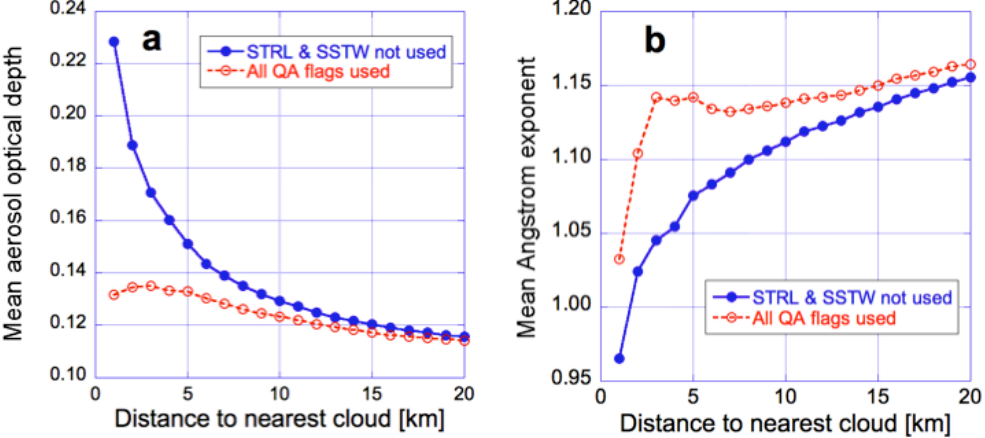
Figure 3. Near-cloud behavior of ( a ) mean 550 nm AOD ( b ) and mean 443–869 nm Angstrom exponent (AE) when using two different sets of Quality Assessment (QA) flags for data selection. The red dashed curves are based on pixels where all QA flags show “no concern”, while the solid blue curves are based on pixels regardless of what the Stray light (STRL) and Sea surface temperature warning (SSTW) QA flags say, as long as the other QA flags show “no concern”. The figure is for the same region of the Northeast Atlantic Ocean (45–50° N, 5–25° W) and the same period (14–29 September 2002–2011) as Figure 2. The figure is based on Figure 5 of [44].